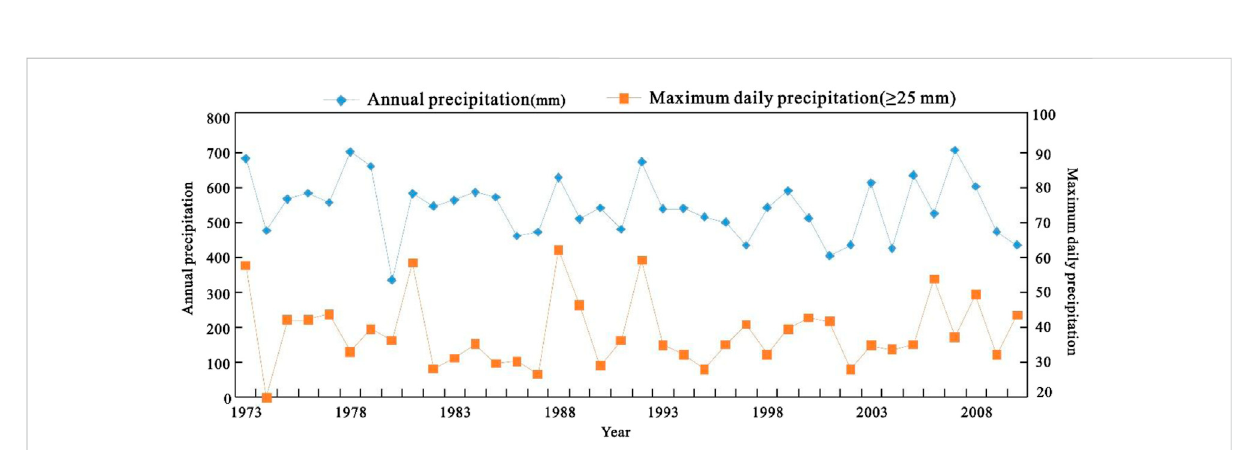
FIGURE 2 Climatic conditions of the study area according to the meteorological station at Dongxiang